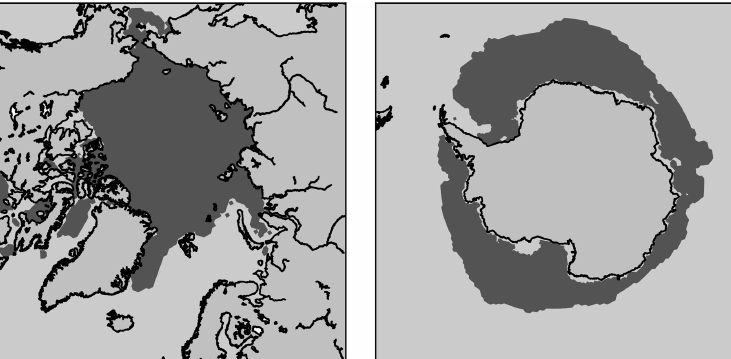
Figure A1. Arctic and Antarctic masks selected for the computation of spatial averages in Figs. 4, 8, A2 and A3. A grid cell is part of the mask if the 1995–2014 mean March (mean September) Arctic (Antarctic) sea ice concentration is greater than 99%.